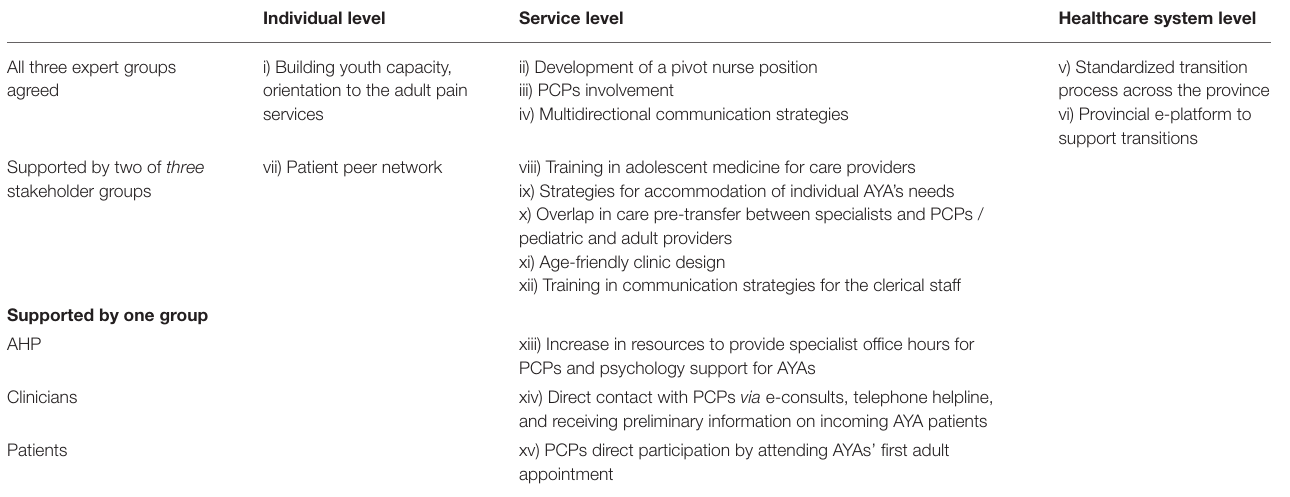
TABLE 1 | Summary of 15 actionable